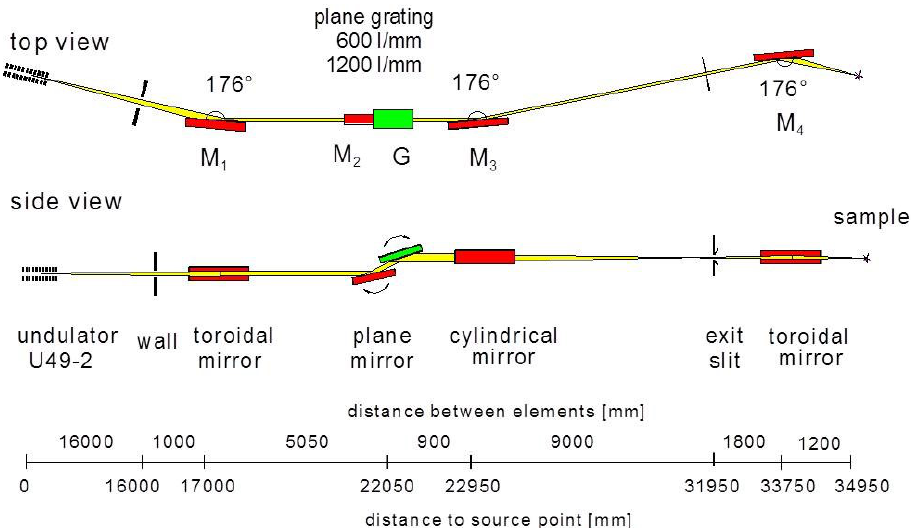
Figure 3: Optical layout of beamline U49/2